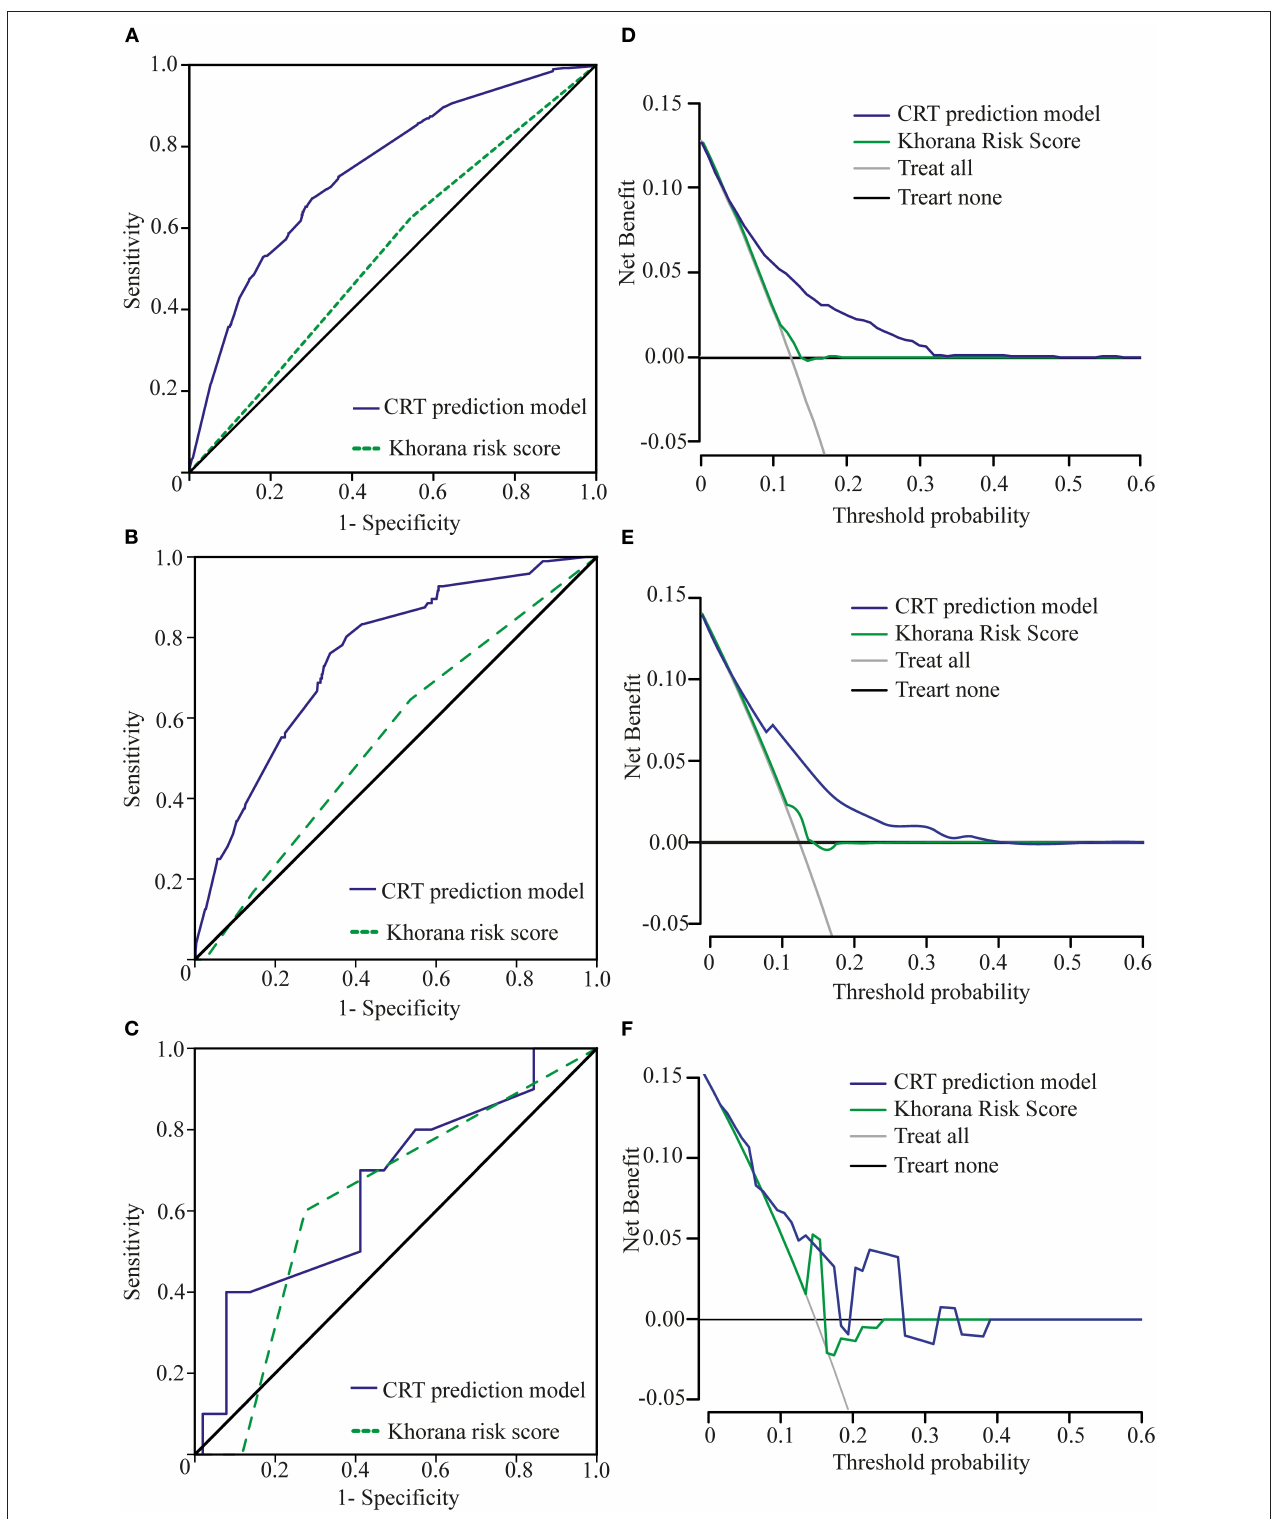
FIGURE 4 | Comparison of ROC curves and net benefits between the Khorana risk score model and the new CRT prediction model. (A) ROC curve of the CRT prediction model and the Khorana risk score model in the primary cohort. (B) Our new model is the higher line on the decision curve, which indicates that the